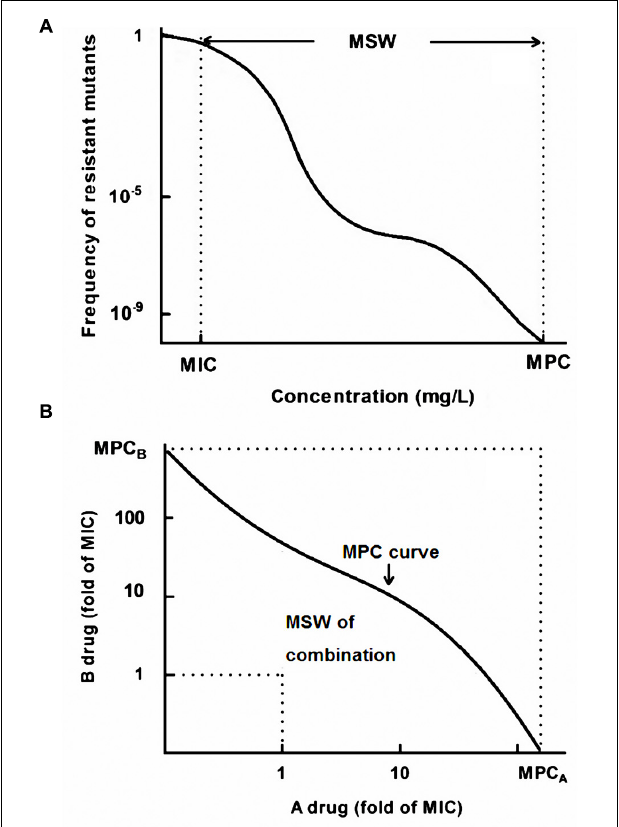
FIGURE 1 | A theoretical model of the mutant selection window (MSW). (A) MSW of a single drug ranging from the MIC to the MPC; (B) The MSW notion in drug combinations extends from the MPC curve to the MIC line (dashed line).